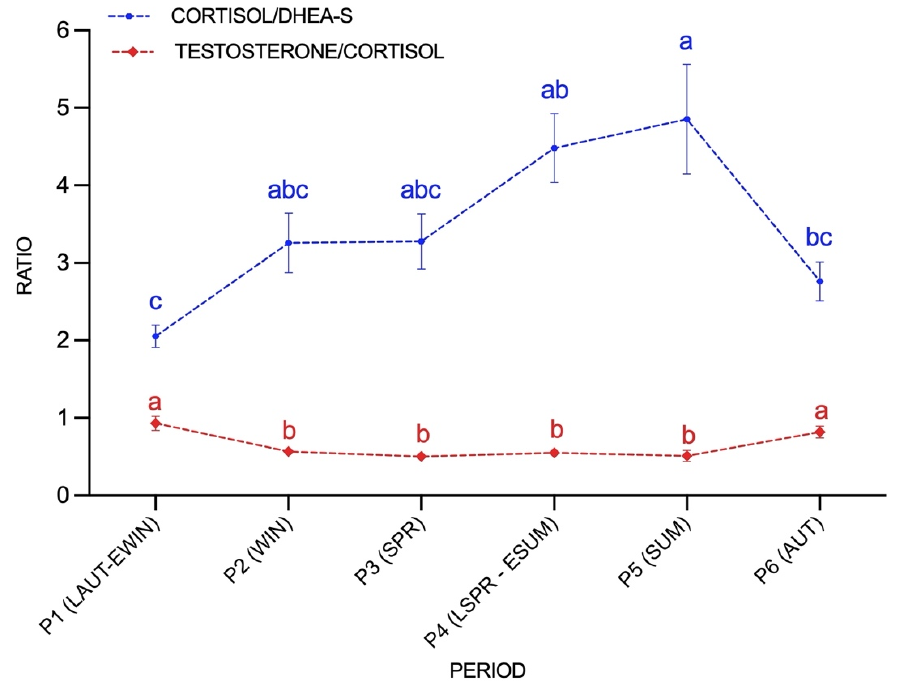
Figure 2. The hair C/DHEA-S ( blue) and T/C ratio ( (cid:7) red) variations during the studied period (P1; late autumn-early winter, P2; winter, P3; spring, P4; late spring-early summer, P5; summer, P6; autumn). Data are graphically presented as mean ± SEM. Different letters represent significant differences between periods ( p < 0.05).